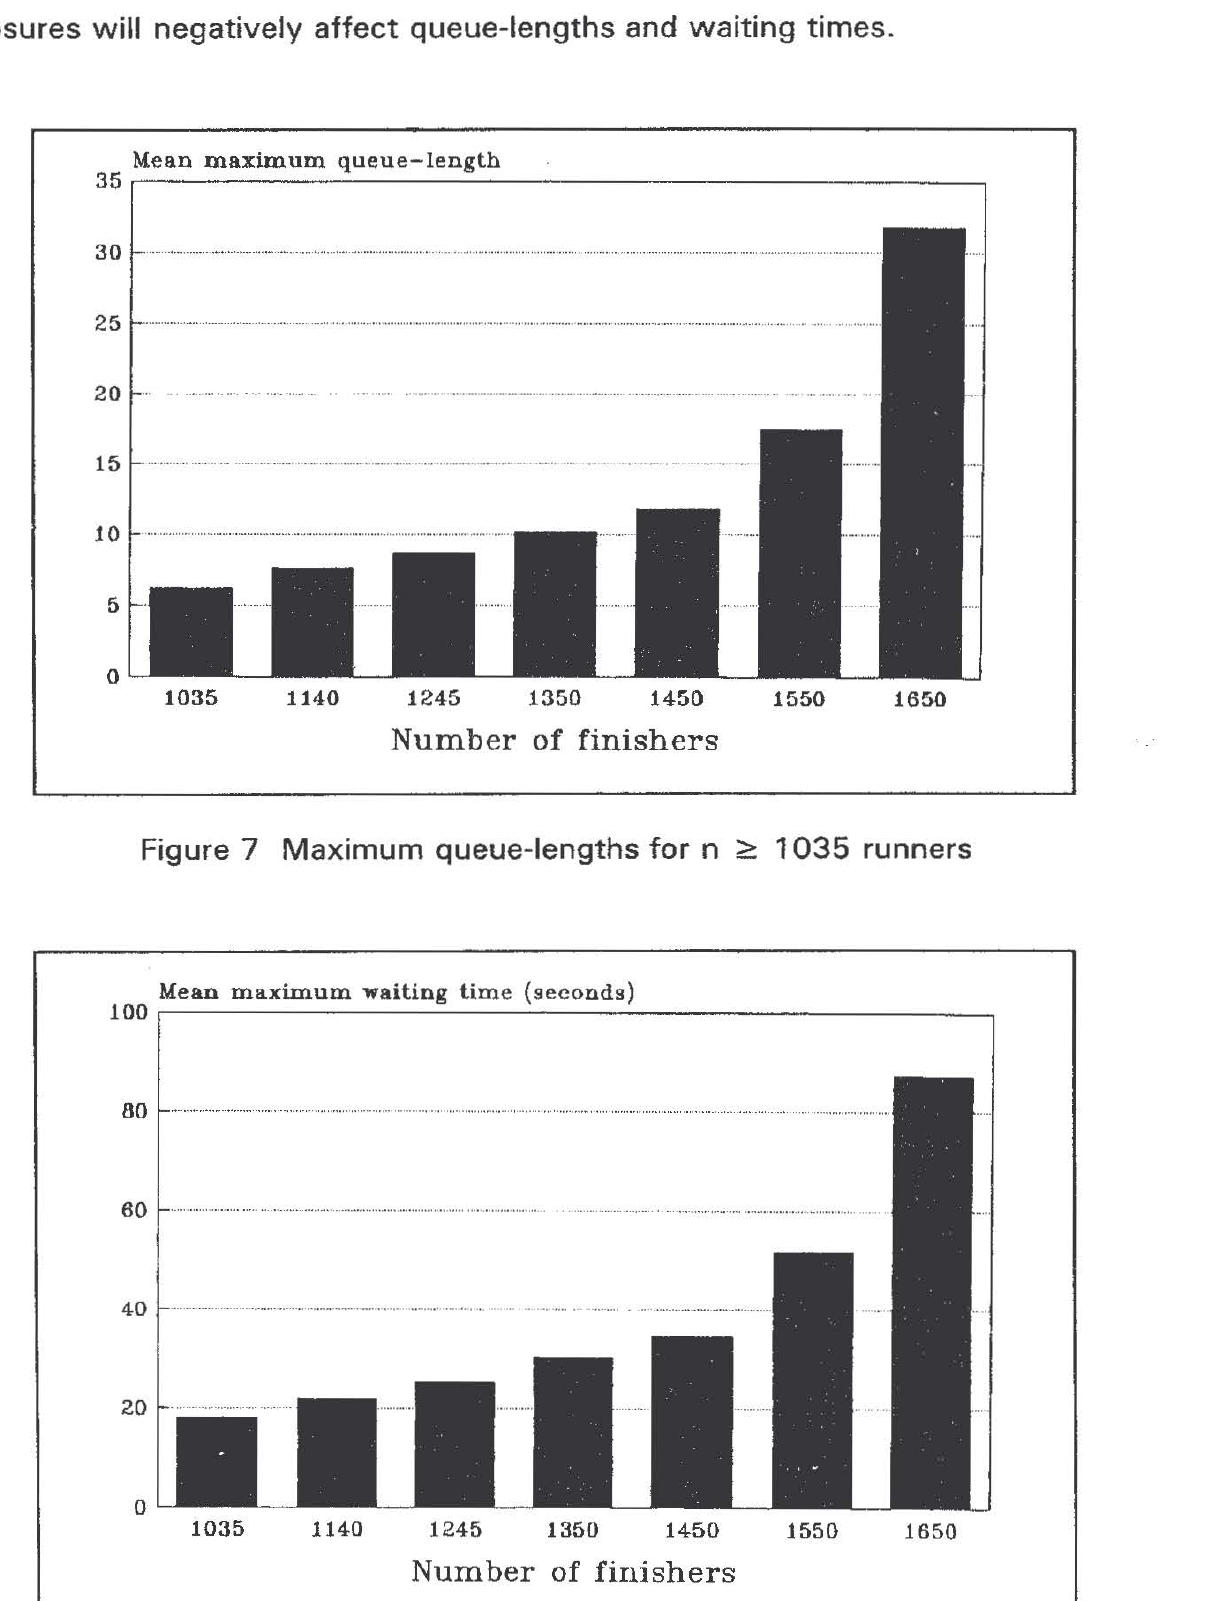
Figure 8 Maximum waiting-times for n > 1 035